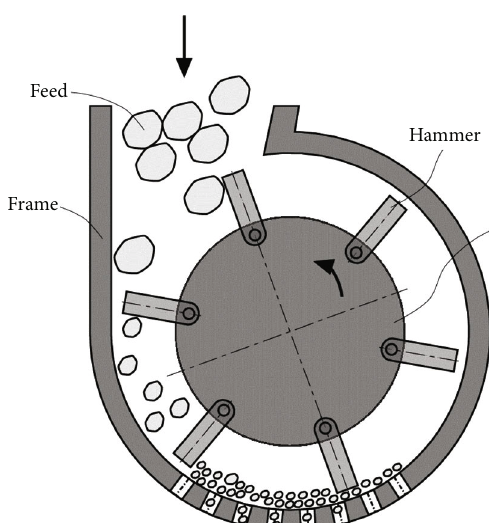
Figure 2: Hammer crusher [10].